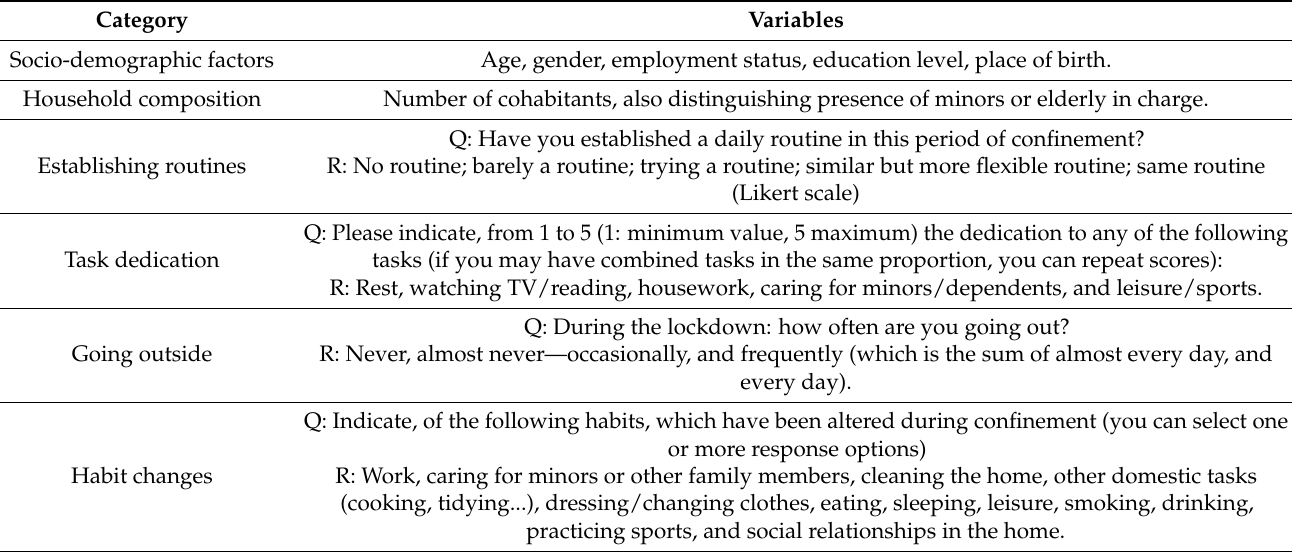
Table 1. Variables grouped by categories used in this study, main questions and possible answers. Category Variables Socio-demographic factors Age, gender, employment status, education level, place of birth. Household composition Number of cohabitants, also distinguishing presence of minors or elderly in charge. Establishing routines